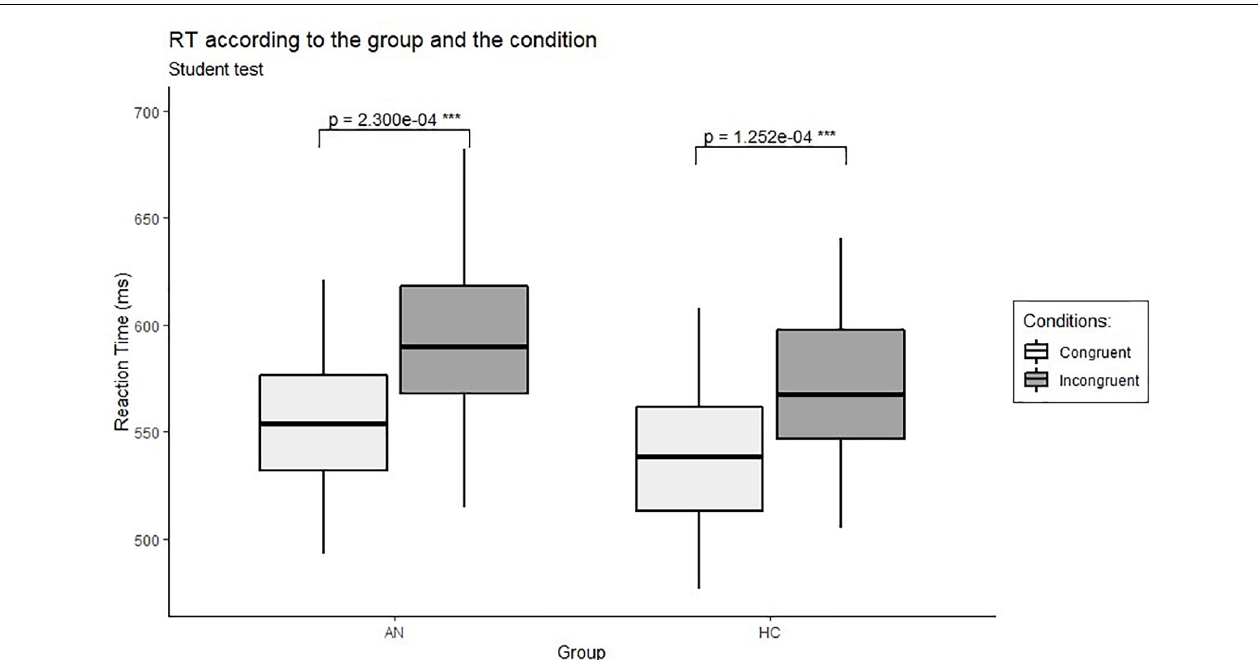
FIGURE 2 | RT (ms) comparisons between conditions within-group. RT, reaction times; AN, AN group; HC, HC group. *** p < 0.001 , the difference between the two groups designated by the trait is